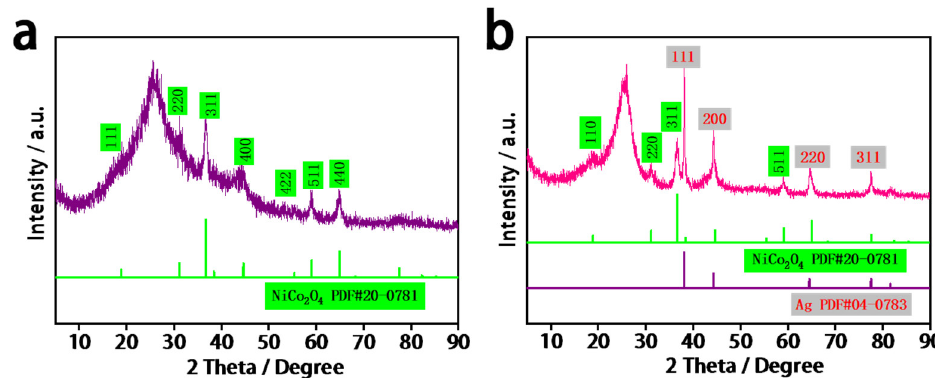
Figure 2. XRD patterns of samples of ( a ) NiCo 2 O 4 -NC and ( b ) Ag/NiCo 2 O 4 -NC.